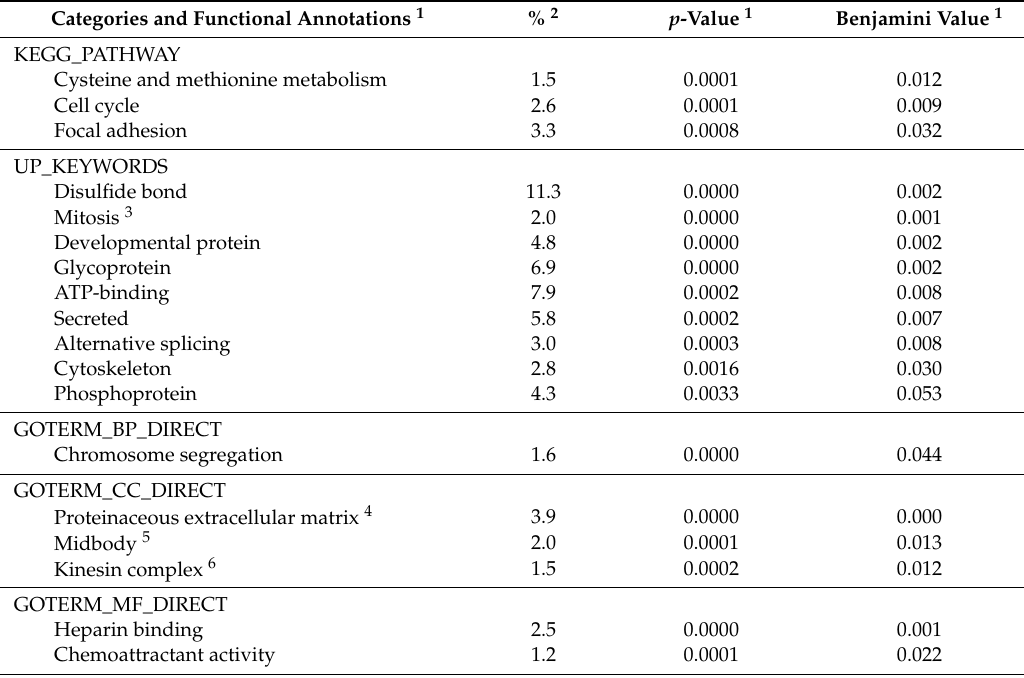
Table 4. List of DAVID (Database for Annotation, Visualization and Integrated Discovery) functional annotation significantly enriched of di ff erentially expressed genes (DEGs) in the cecal mucosa of broiler